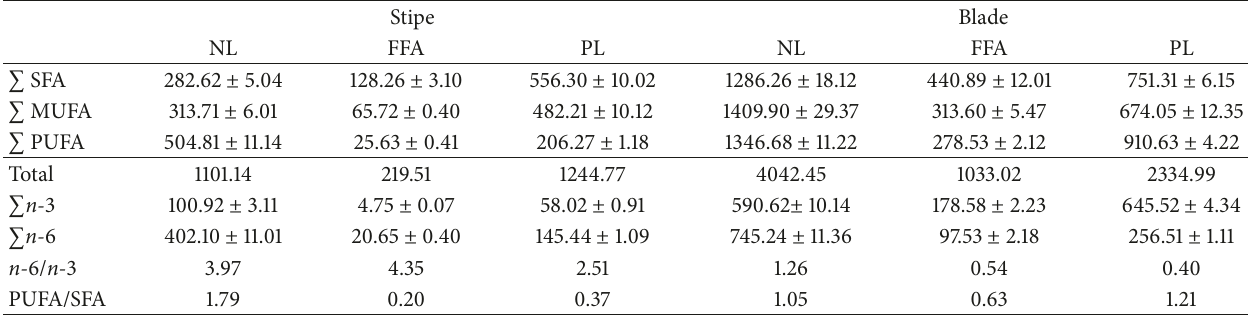
Table 2: Sum of SFAs, MUFAs, and PUFAs, as well as n -6 and n -3 in L. hyperborea given in 𝜇 g/g DW, ( 𝑛 = 4 , two injection parallels for each sample replicate).